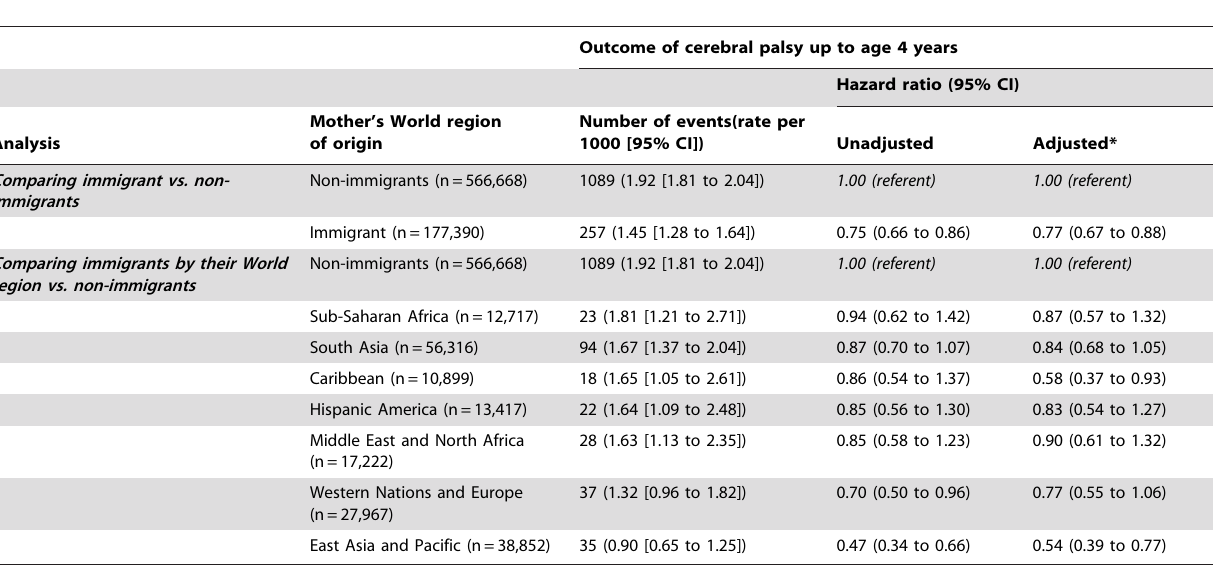
Table 2. Main model analyses examining the risk of childhood cerebral palsy by maternal immigration status (upper) and by immigrant World region of origin (lower), each compared to